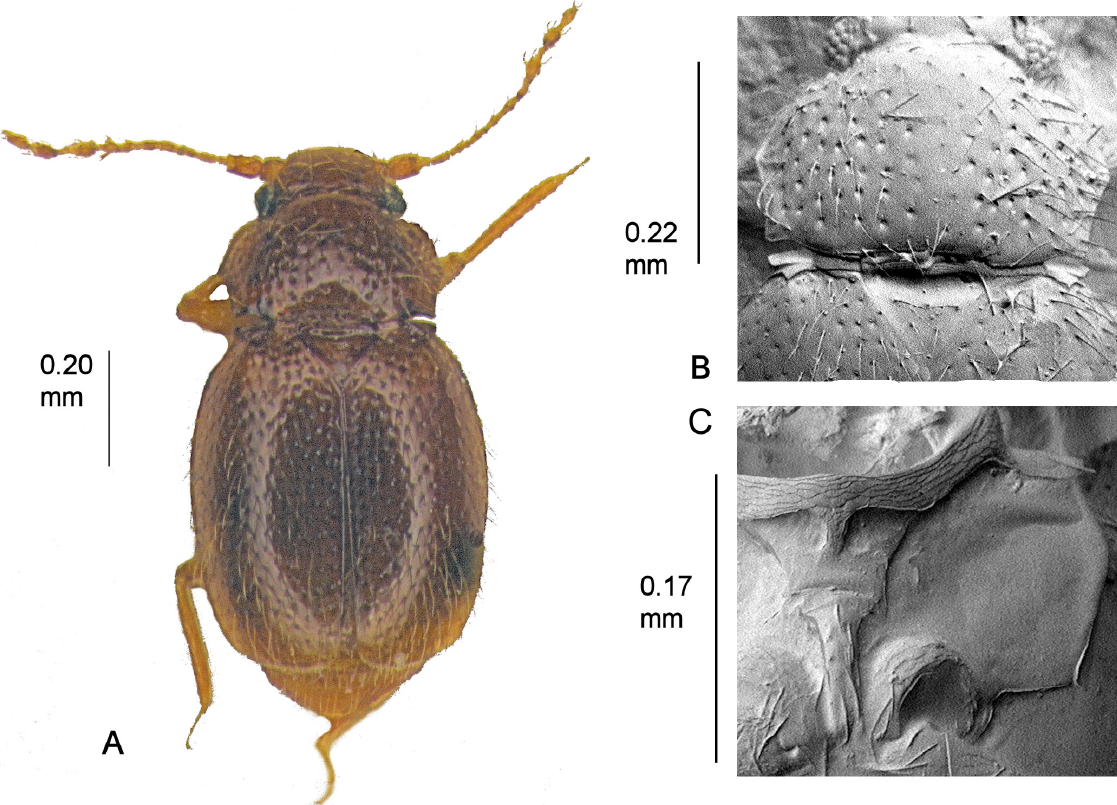
Fig. 46 . Cissidium amazonicum sp. nov. A . Habitus. B . Pronotum, × 365. C . Mesoventrite showing median process of collar, mid-keel, keel and lateral margin, ×